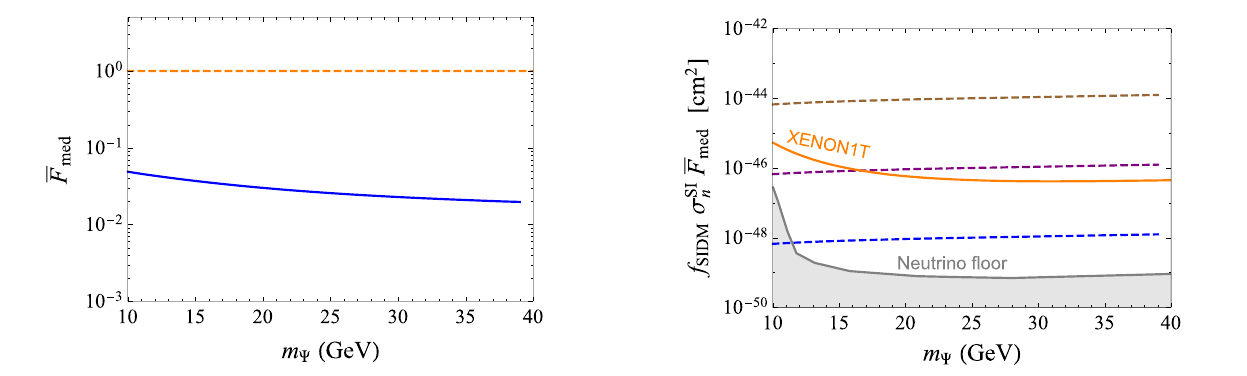
Fig. 6 The SIDM–nucleon SI scattering cross section in the form of f SIDM σ SI n F med as a function of SIDM mass, with m φ = 20 MeV. The dashed curves from top to bottom are the scattering cross section f SIDM σ SI n F med for the case of θ mix = 10 − 7 , 10 − 8 , 10 − 9 , respectively. The upper, lower solid curves are the upper limit from XENON1T [9], the detection bound of the neutrino floor [71]